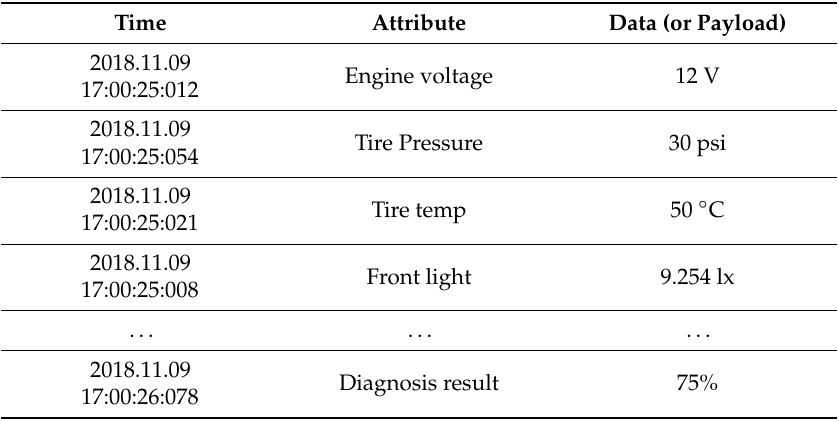
Table 1. Example of the data collection